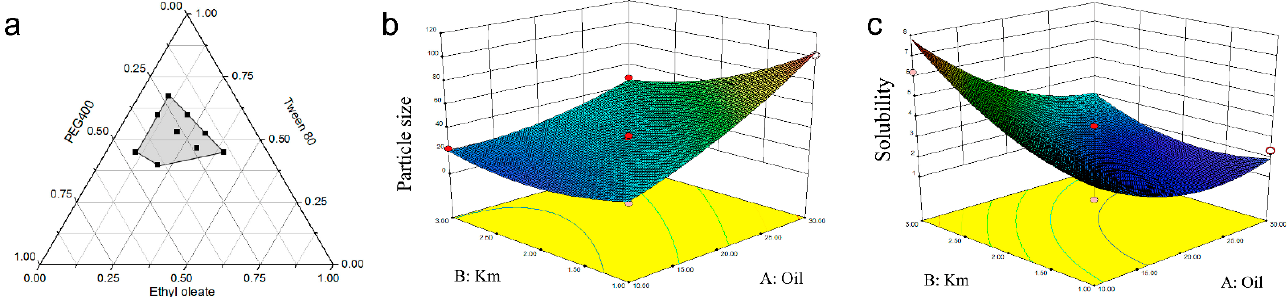
Figure 5. Tertiary-phase diagram showing emulsion areas (in grey color) of the selected masses of the independent variables containing surfactants (i.e., PEG400 and Tween 80 (K m )) and oil phases (i.e., ethyl oleate) ( a ). Interaction effects in three-dimensional response surface plots for CCD be- tween K m and oil on particle size ( b ) as well as on solubility ( c ). Adapted from Zheng and coworkers